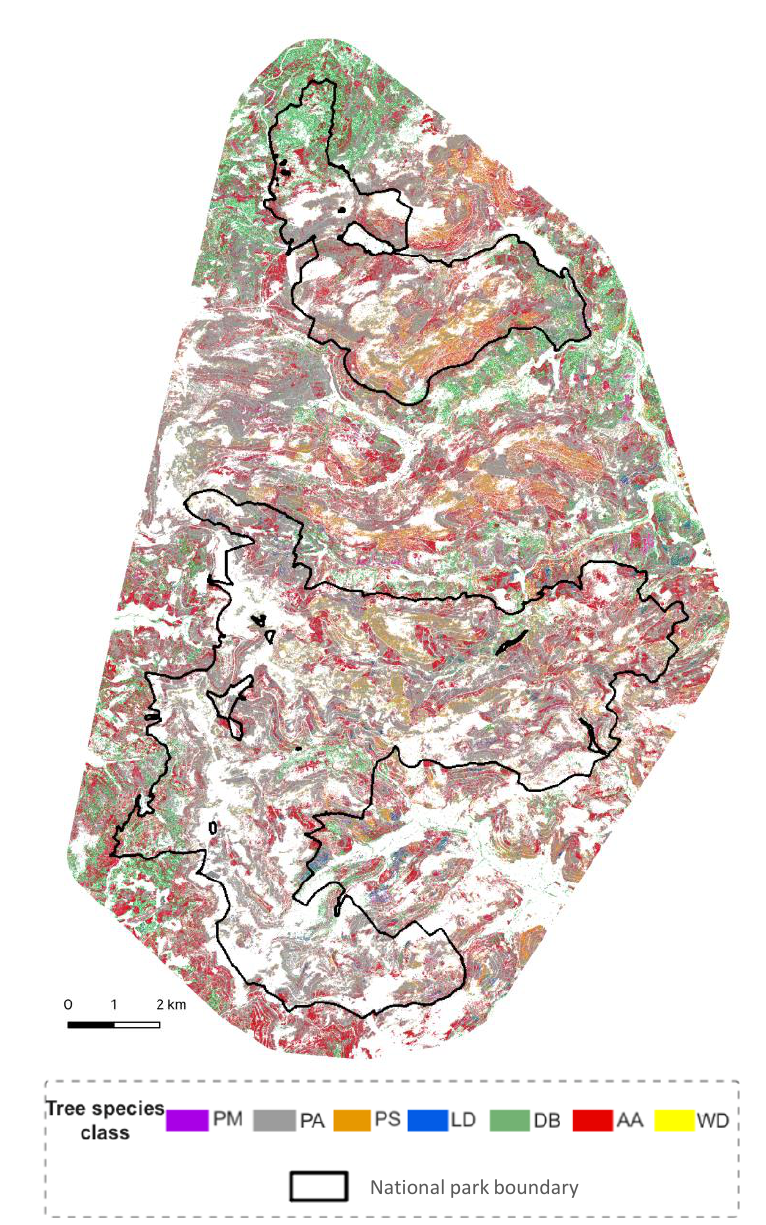
Figure 6. The classified tree classes as result of the applied classification model for the entire study